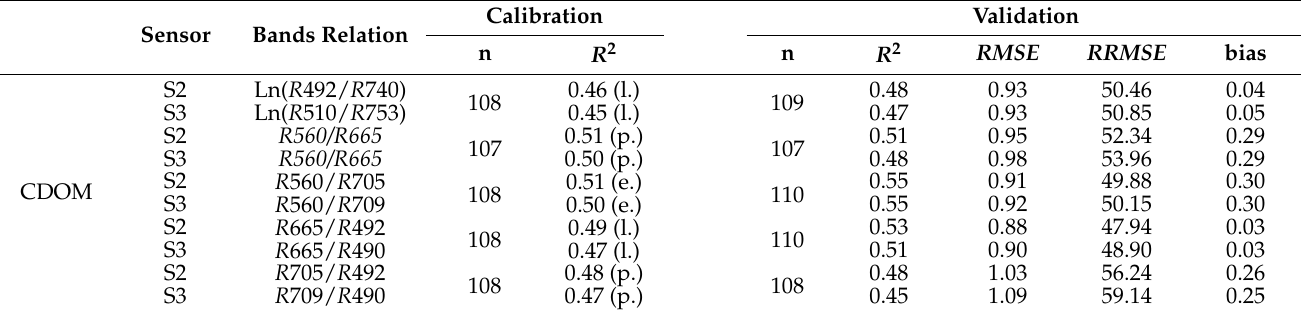
Table 6. Calibration and validation results for colored dissolved organic matter (CDOM). Only results with a calibration with R 2 > 0.4 are shown. Regressions: linear (l.); potential (p.); exponential (e.). RMSE ( µ g/L QSE); RRMSE (%); bias ( µ g/L QSE). Calibration Sensor Bands Relation